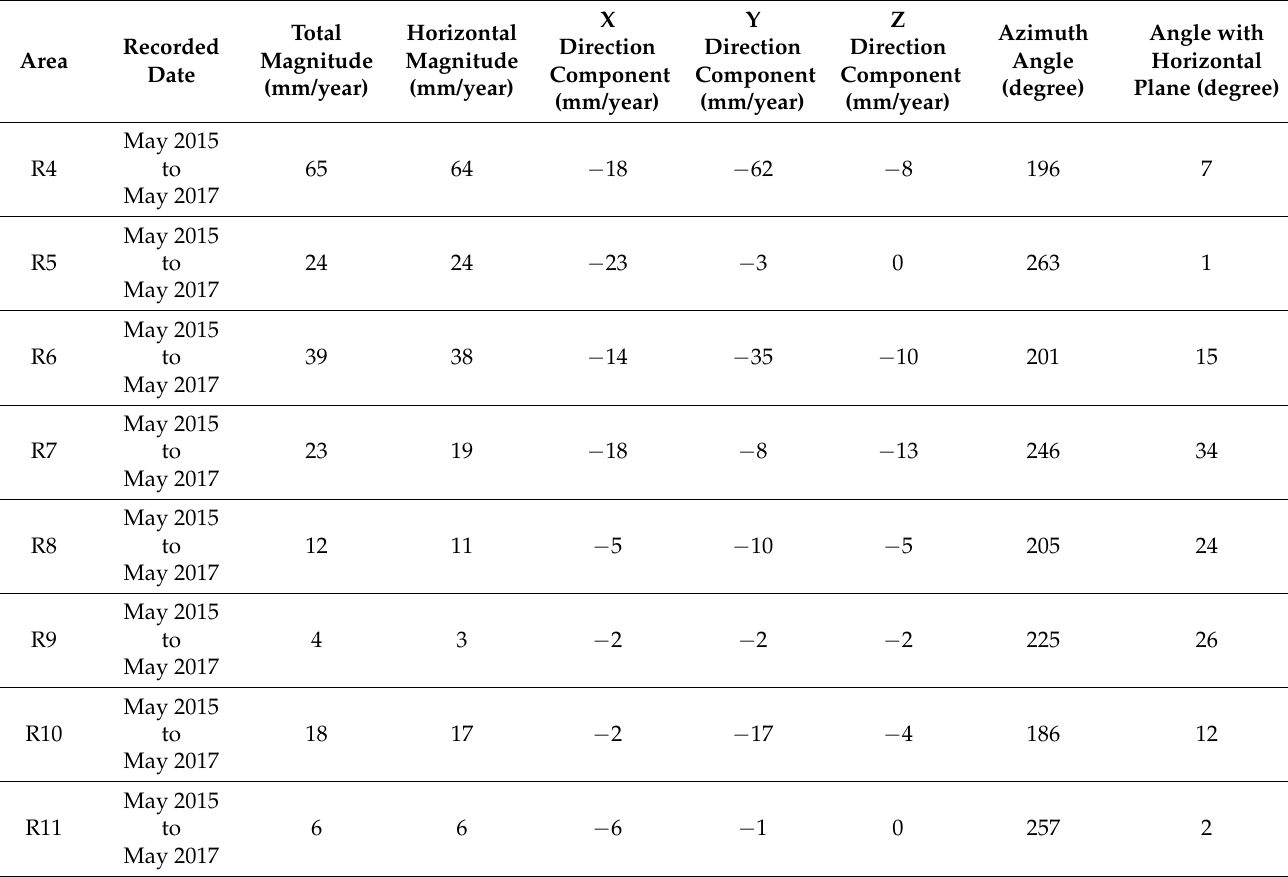
The Barnard landslide cumulative 2-year LOS displacements are shown in Figure 20. The magnitudes of LOS displacements are larger at and near the toe of the landslide. The time series of the 2-year cumulative LOS displacements are shown in Figure 21 for all sectors of the Barnard landslide. The magnitude of the cumulative LOS displacement in these 2 years ranges between +30 and − 30 for both orbits. The calculated horizontal components of R on the Barnard landslide are shown in Figure 22. The magnitude of the horizontal displacements is between 2 and 18 mm/year, with the maximum horizontal displacement at sector 2, in the center of the landslide. The vertical components of R are shown in Figure 23. Ground displacements are near horizontal at or near the toe of the landslide, while the vertical component of ground displacements increases in sectors to the east of the landslide. The higher vertical components of R near the crest, transitioning towards near horizontal movement and showing some upward component near the toe, suggest a predominantly circular kinematic